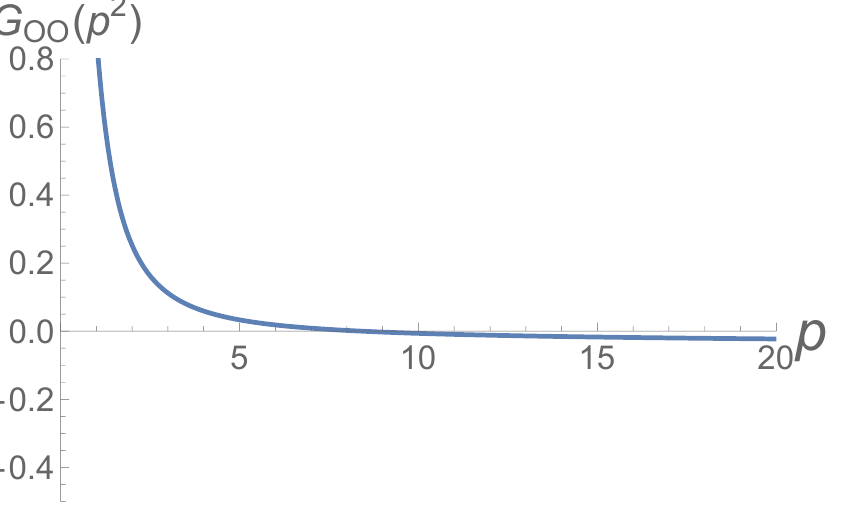
Figure 3 . Resummed propagator for the scalar composite operator. All quantities are given in units of appropriate powers of the energy scale (cid:22) , with the parameter values e = 1, v = 1 (cid:22) , (cid:21) = 1